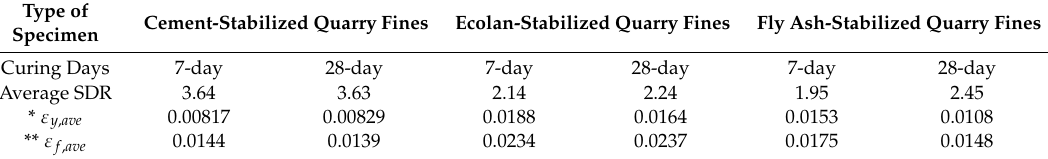
Figure 5. Strain–ductility ratio from stress–strain relationship. Table 3. Strain–ductility ratio of stabilized quarry fines at 7-day and 28-day ages.